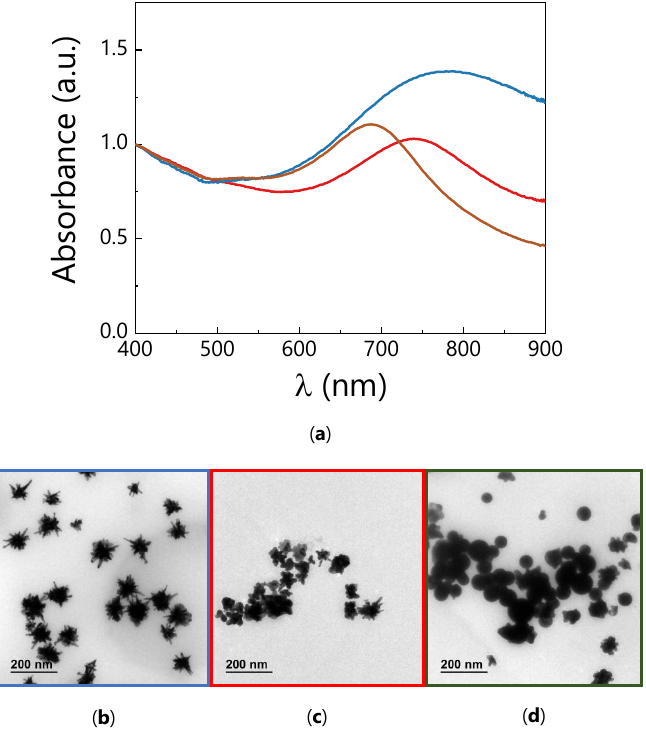
Figure 4. ( a ) Normalized UV-Vis-NIR spectra of the lipoplex-AuNS system (100 pM AuNSs) under non-irradiated (blue line) and irradiated conditions, at 400 mW (red line) and 700 mW (brown line) for 5 min. TEM micrographs of lipoplex-AuNS systems (100 pM AuNSs) under non-irradiated ( b ) and irradiated conditions at 400 mW ( c ) and 700 mW ( d ) for 5 min.